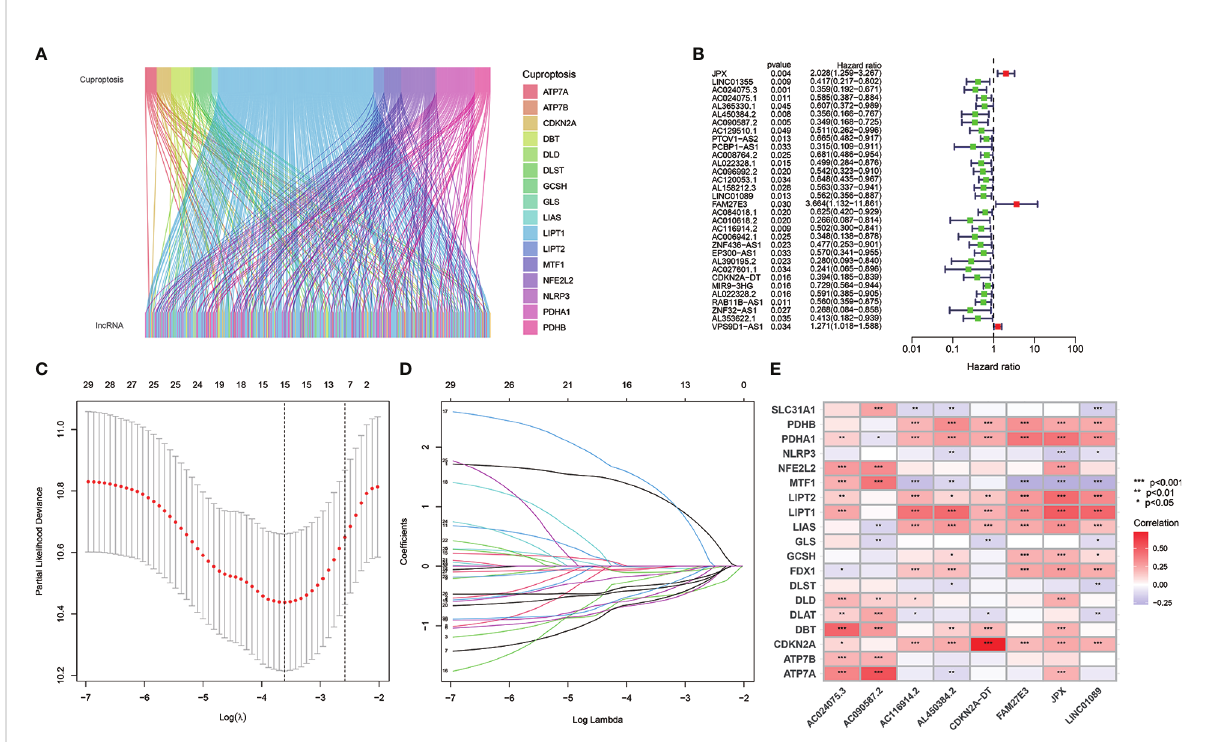
FIGURE 2 The cuproptosis-related lncRNAs identi fi cation and risk model for HNSCC patients. (A) Nineteen cuproptosis genes and cuproptosis-related lncRNAs are shown in the Sankey relational diagram. (B) Univariate Cox regression was conducted for assuring the selected lncRNAs and fi guring out the correlation with clinical prognosis. (C, D) LASSO regression analysis following minimum criteria. (E) A heatmap intended to express the relationship between 19 cuproptosis genes and the eight cuproptosis-related